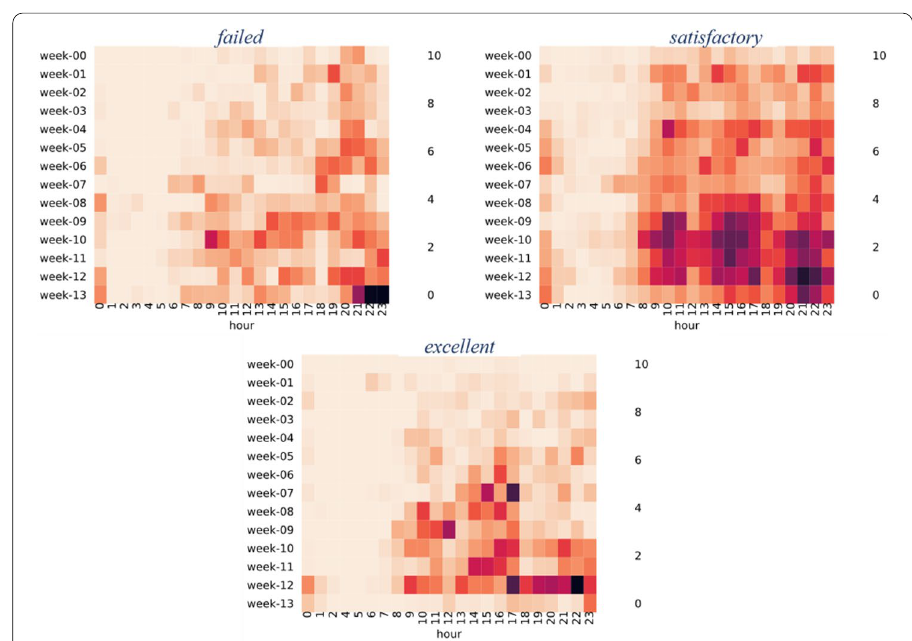
Fig. 1 Heat map of the three groups’ learning time